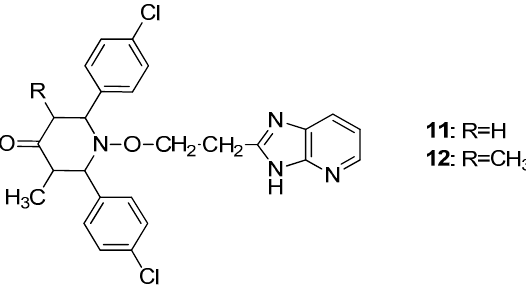
Figure 5. Antibacterial imidazo[4,5- b ]pyridines.